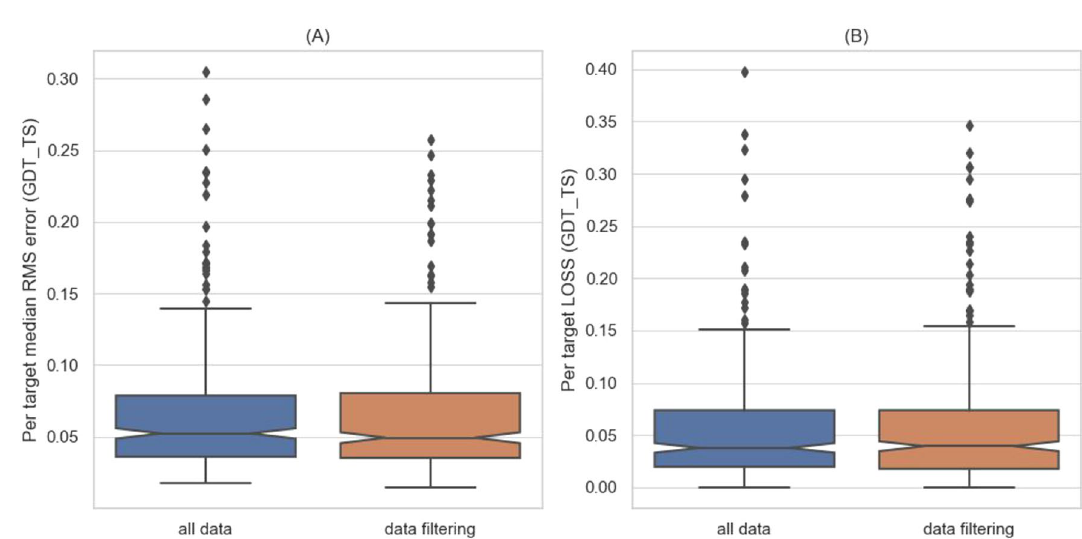
Figure 3. Filtering out outlier targets from the training set reduces the error in quality estimation ( A ), and does not affect the identification of the best models ( B ). The box plots depict the results of Leave-One-Target-Out experiments with and without data filtering in the training set. (A) The median of the RMSE is significantly reduced by data filtering (Wilcoxon one-sided test, with a p-value of 0.005). (B) Data filtering does not affect the distribution of LOSS (the quality differences between the top-ranking model, and the best model in the set). Many of the worse performing outliers in the plots are proteins that were filtered out from the training